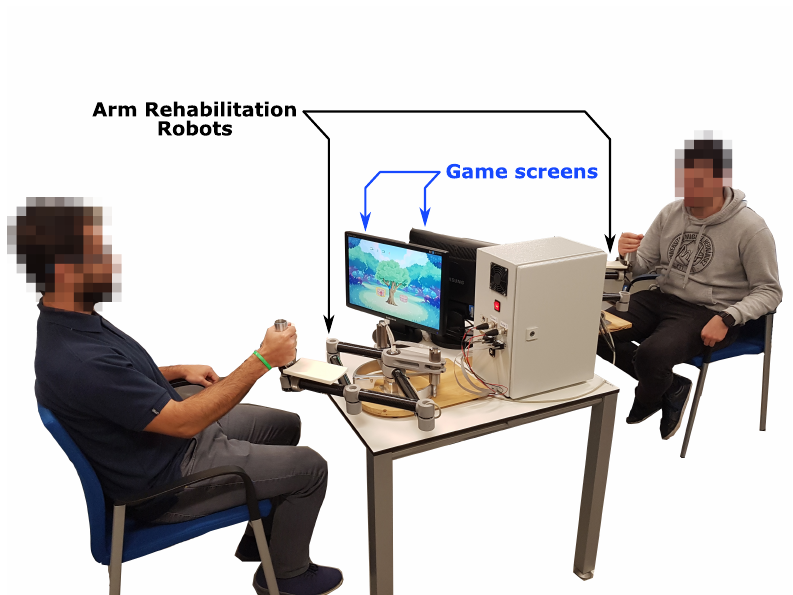
Figure 1. Overview of the experimental setup with two participants.